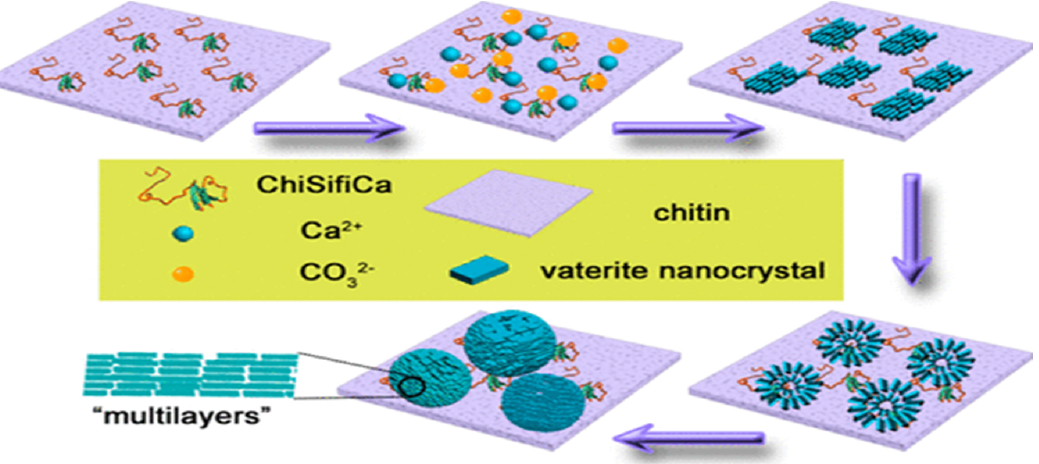
Figure 11. Schematic of CaCO 3 mineralization directed by ChiSifiCa on the surface of chitin. This Figure is adapted with permission from [62].